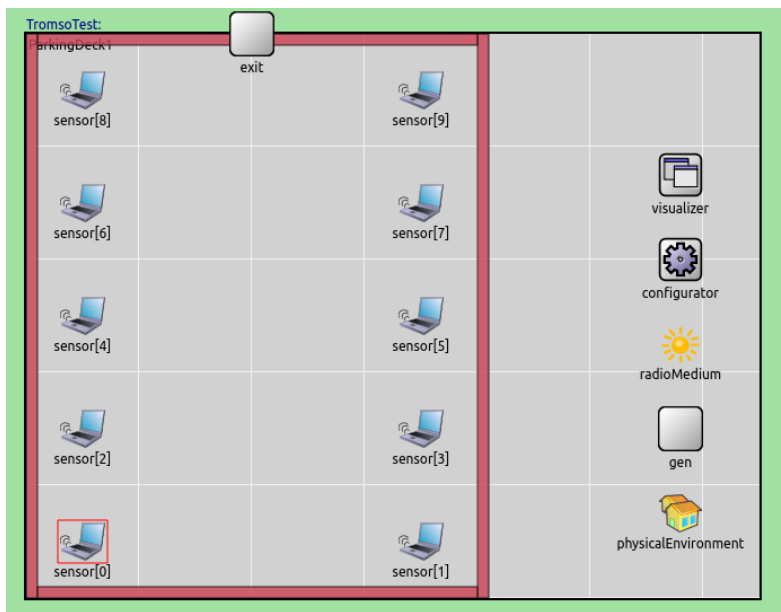
Figure 7. Smart energy use case: Omnet++ model of parking deck at Level